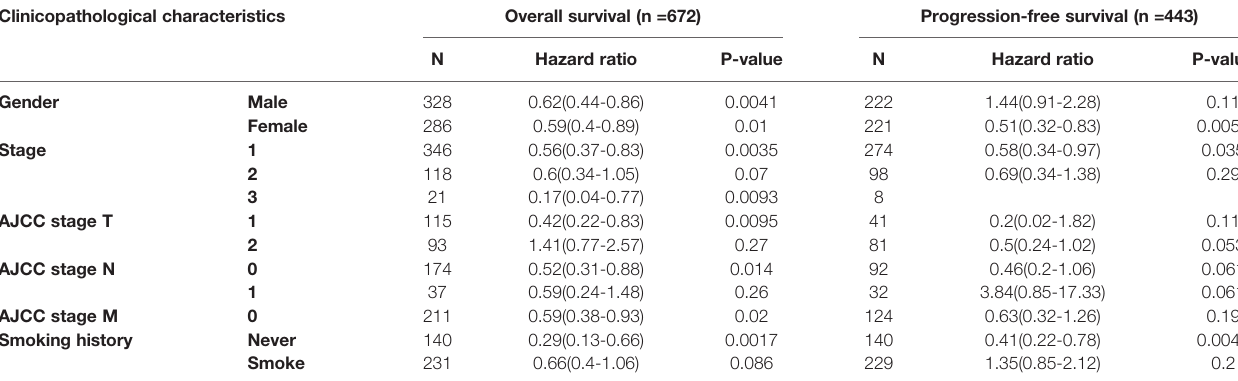
TABLE 1 | Correlation between TTN mRNA expression and clinical prognosis in LUAD with different clinicopathological factors by Kaplan-Meier plotter. Clinicopathological